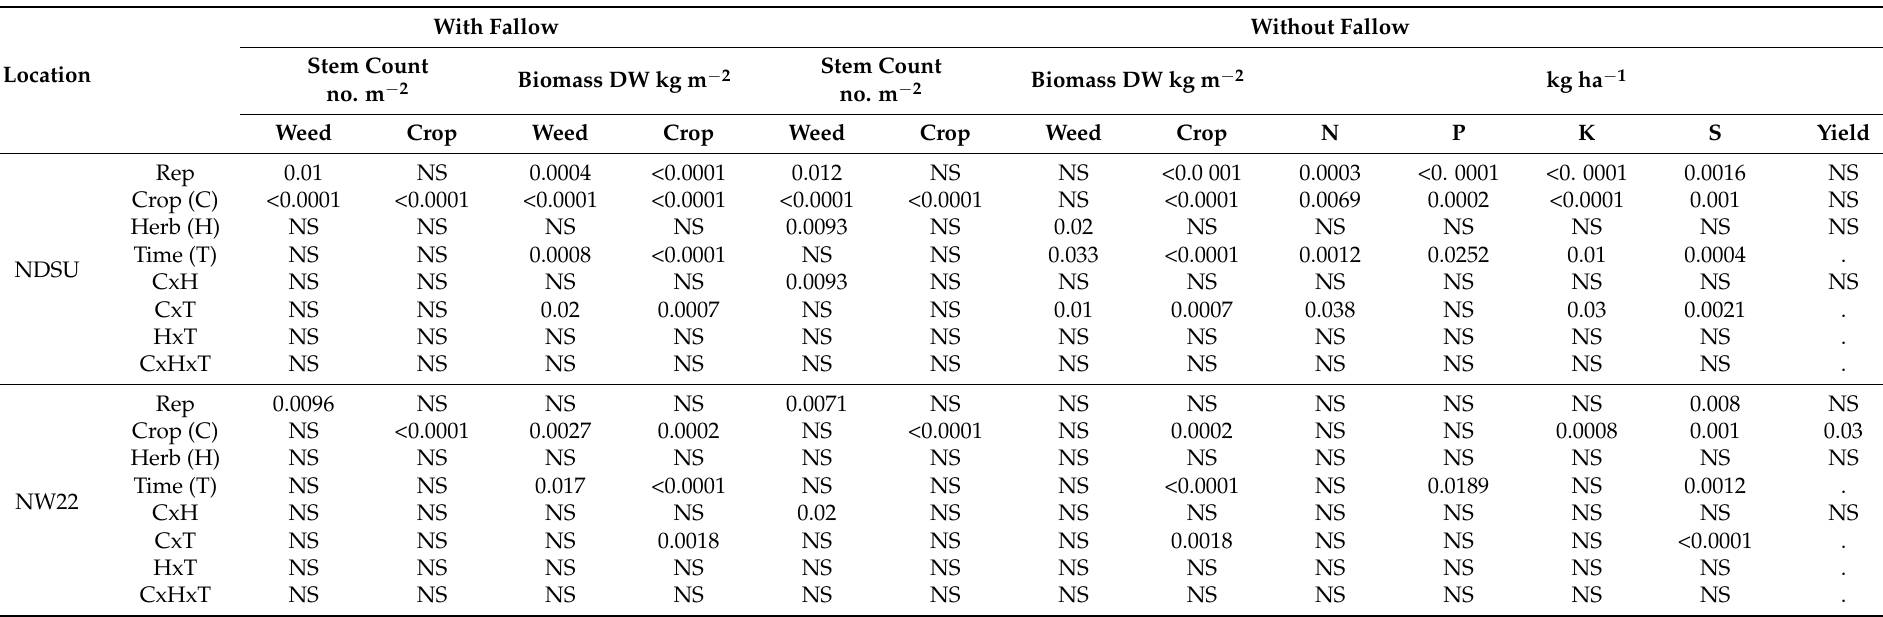
Table 1. ANOVA table showing level of significance ( p -values) on stem counts, dry weights (DW), nutrient content (N, P, K, S) and final season crop seed yield (yield) at NDSU and NW22. Stem count and DW were analyzed with and without fallow